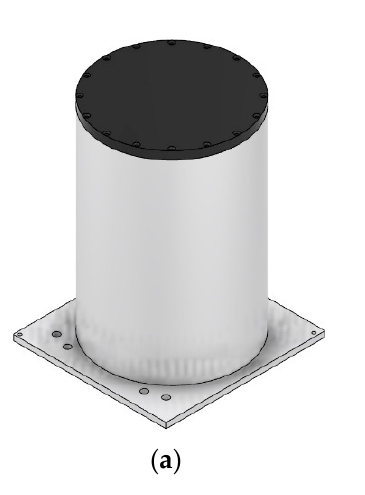
Figure 2. ( a ) CAD model of the designed lid. An aluminum cylinder (250 mm × 15 mm × 360 mm) with a polycarbonate plate (250 mm × 15 mm) was fixed with screws to a rectangular aluminum plate (282 mm × 293 mm × 10 mm). ( b ) Measurement setup with the lid fixed to the FTIR spectrometer with the long-path gas cell inside. The gas inlet was connected to one of the bulkhead fittings on the outside of the lid, and a second bulkhead fitting was connected to the gas exhaust. The inlet and the outlet of the long-path gas cell were connected to the respective bulkhead fittings on the inside of the lid. Table 1. Parameters used for the transmission measurements with the FTIR spectrometer (Vertex 80v,